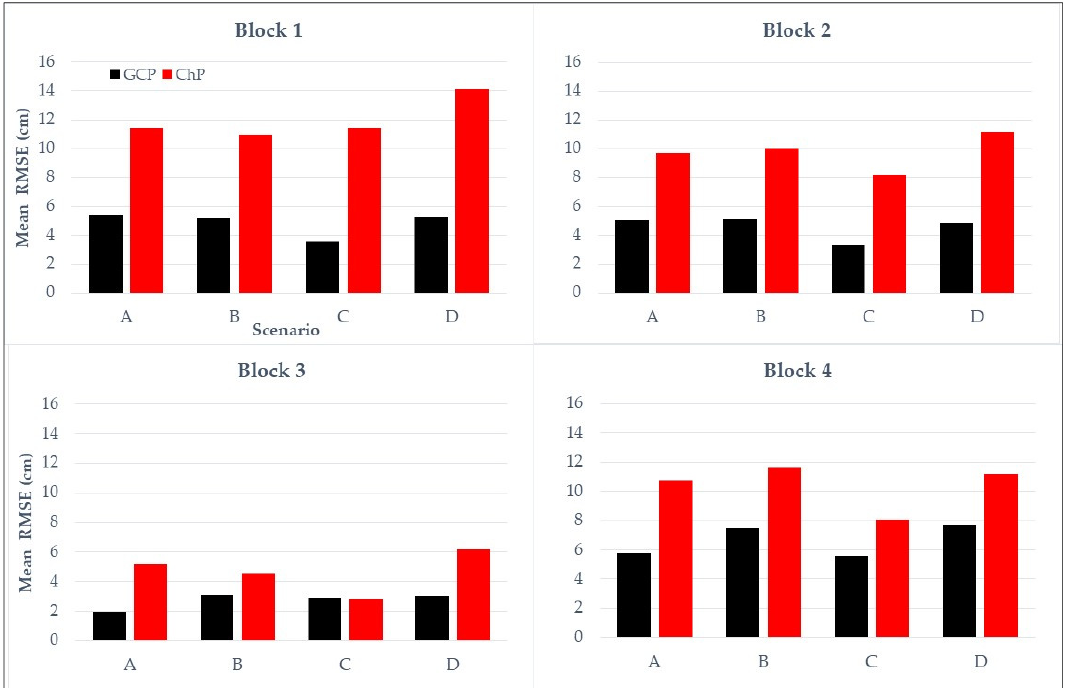
Figure 9. Distribution of the mean RMSE of the GCPs and ChPs of the four blocks for the scenarios studied (for A, B, C & D, vid. Section 2.3 and Figure 7).